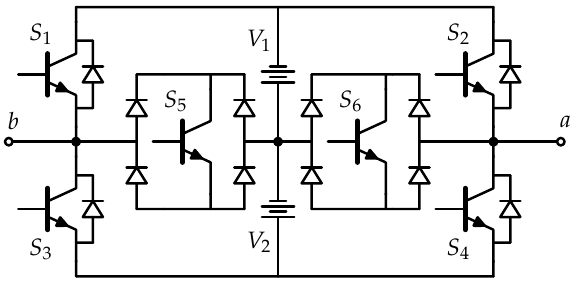
Figure 1. Structure of the proposed topology as a